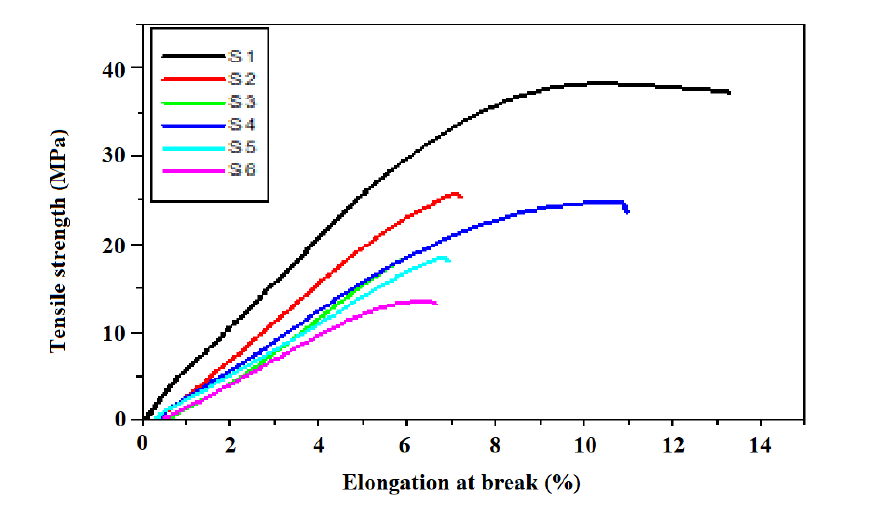
Fig. 7. Stress-strain curves of the 6 different